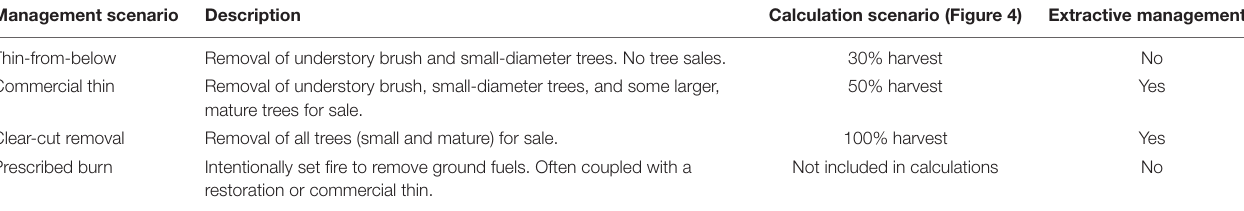
TABLE 1 | Common management scenario types in western United States forests.